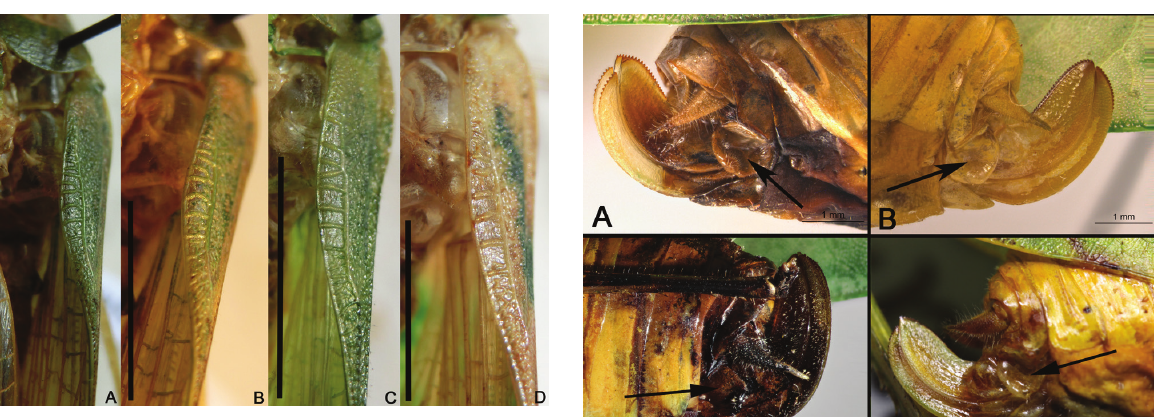
Description. Male. Color dark and shiny green, with few ivory to orange patches on tegmina; tergites of abdo - men vivid yellow, venter whitish to light green; fore femora dorsally light brown, same colour as tarsi (Fig. 14). Head and antennae . Antennae thin, green, surpassing tegmina by about 1/3. Eyes round, brown-red. Thorax . Pronotal disc flat with sharp lateral edges, anterior margin v-shaped incurved, posterior margin of disc broadly rounded as de- scribed for genus (Karsch 1889). Lower margin of pronotal lobes broadly rounded, deeper than long, with sharp edge where wings are inserted. Tegmina broad, posterior end broadly truncate. Stridulation area tri-angle shaped flat on same level as pronotal disc as typical for genus. Stridulato- ry file as in Fig. 4B. Alae surpassing tegmina, in this area of same dark green shiny colour; with acute tips. Femora ventrally with spines. Fore tibiae slightly inflated in area of tympana. Abdomen . Last abdominal tergite with straight posterior margin (Fig. 3D). Cerci stout and setose; at